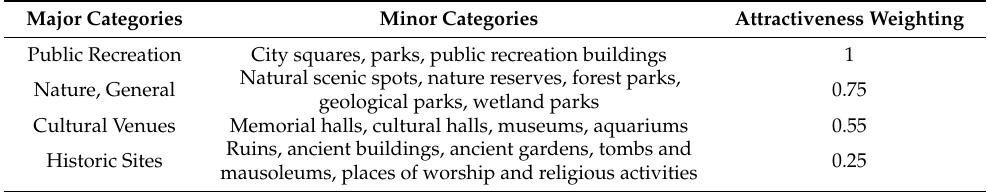
Table 3. The classification of parks and squares and their attractiveness